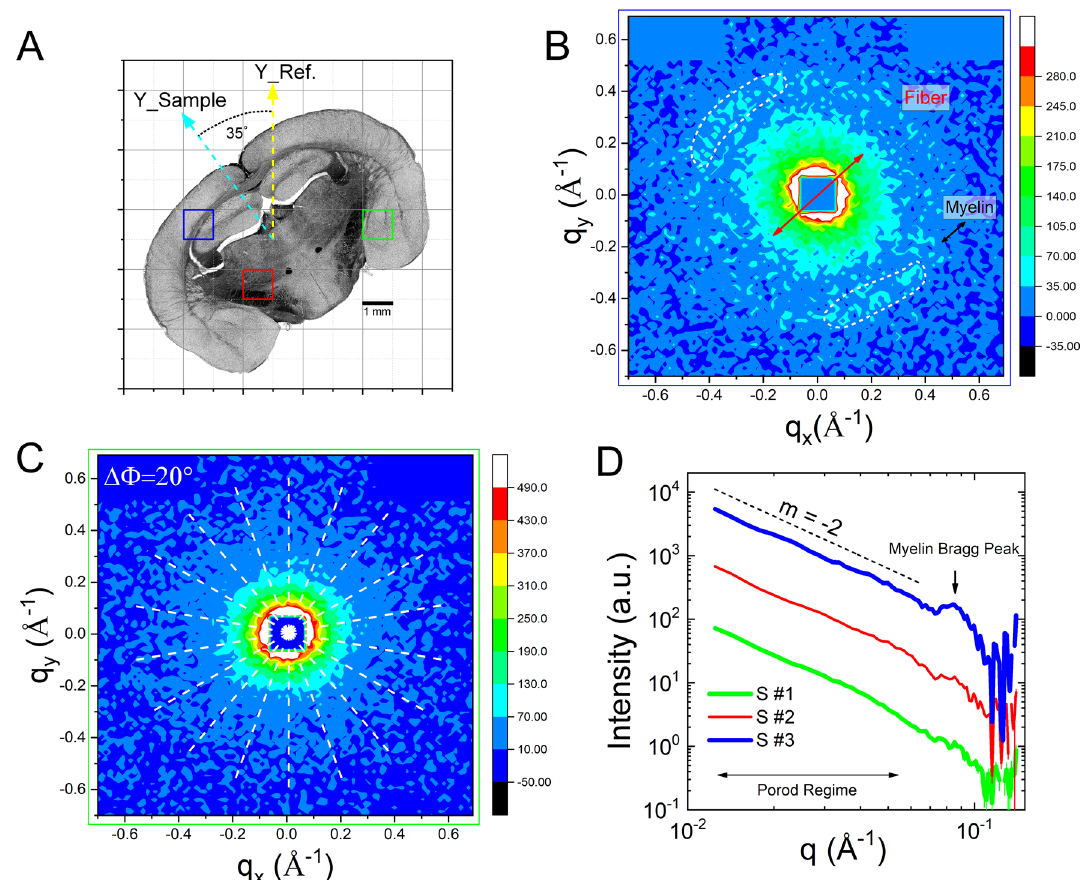
Figure 2. ( A ) A polarization-independent light transmission microscopy image of the coronal section of the reeler mouse brain. Few scanning areas are labeled (square boxes of different color) for reference. ( B ) A typical SANS pattern in q- space ( q x , q y ) obtained at the cc region (blue square box). There is a pronounced low-q scattering with a notable anisotropy indicated by the red arrow, and a pair of DS arcs with an anisotropic diffraction intensity indicated by the black arrows corresponding to the collateral alignment of the bilayer membranes in the myelin sheaths inside the callosal commissure. ( C ) A typical SANS pattern in q- space obtained in a subcortical nucleus (green square box), showing isotropic scattering at low- q , without having any DS arc. ( D ) Azimuthally averaged SANS-intensity as a function of the scattering vector ( three different positions in the brain section (square boxes in ( A ) with similar color). The data are shifted vertically by a factor of 10 for clarity. The scattering intensity varies with a characteristic q −2 power law at low- q . The myelin Bragg peak is observable near 0.083 A −1 and their intensity drastically depend on the position inside the brain section undergoing the